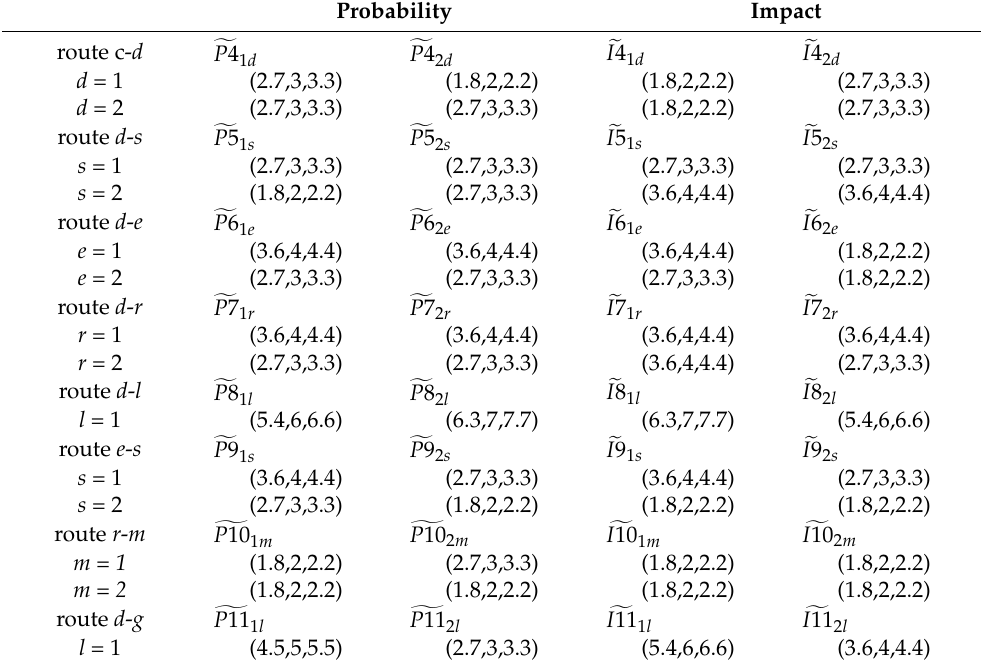
Table 15. Probability of accident occurrence and the impact of shipping between sites.